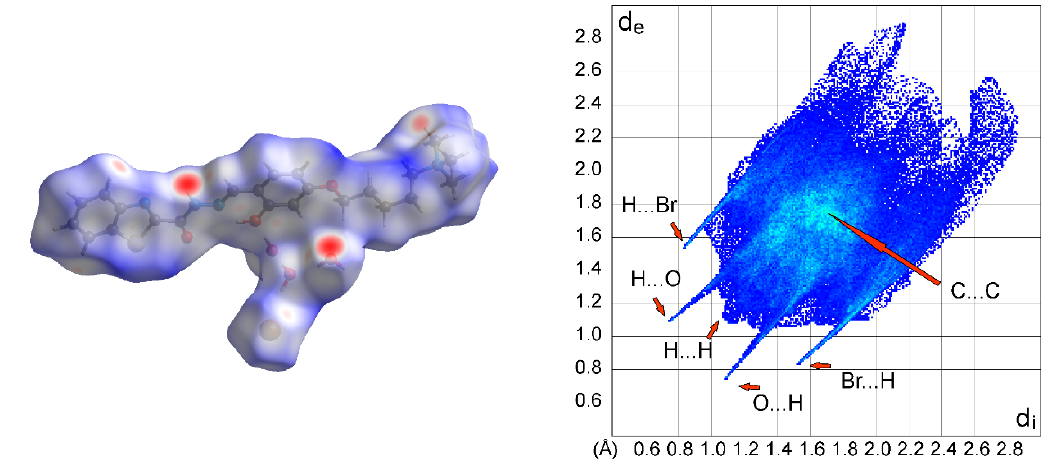
Figure 5. Left : Two-dimensional full fingerprint plot of BTABr. Significative contacts: H. . . H (46.2%), O. . . H / H. . . O (12.9%), Br. . . H / H. . . Br (10.8%), and C. . . C (2.7%). Right : Hirshfeld surface mapped over d norm .